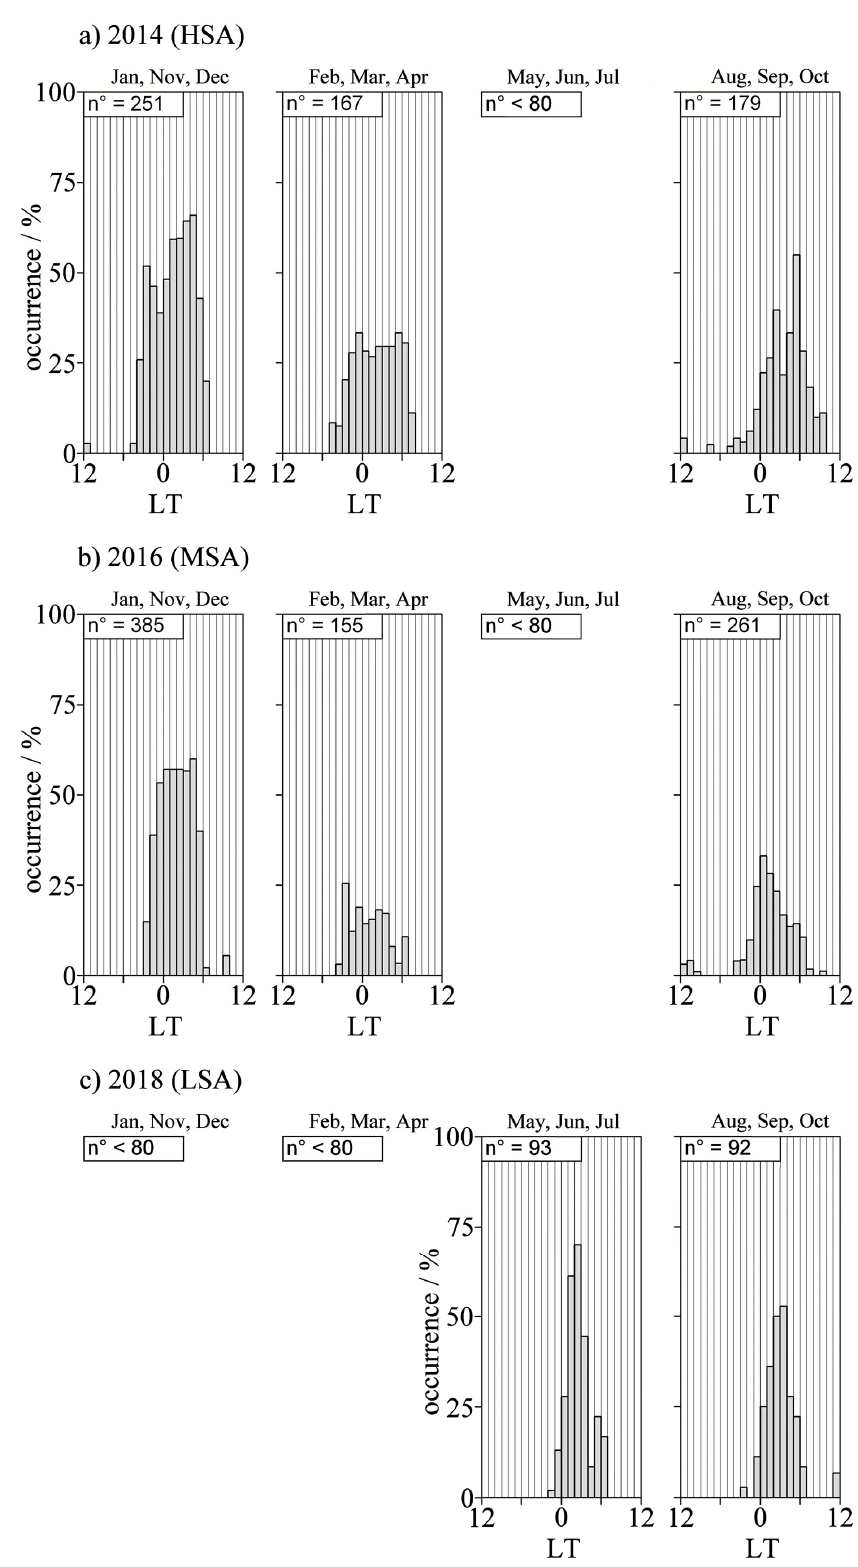
Figure 4. The occurrence of spread F as a function of LT in 2014 (HSA) ( a ), 2016 (MSA) ( b ), and 2018 (LSA) ( c ), for a p ≥ 27. Only the histograms derived from more than 80 cases of spread F are shown.